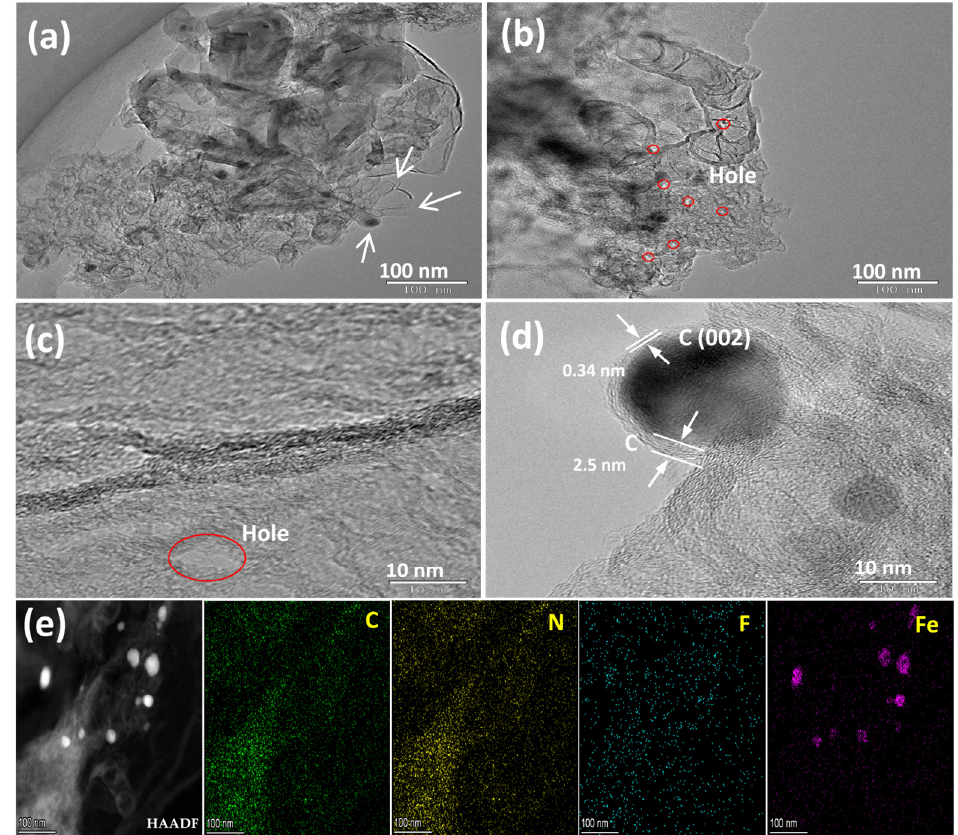
Figure 1. ( a , b ) TEM images and ( c , d ) HRTEM images of Fe 3 C@N-F-GCNTs (the white arrows in ( a ) show the bamboolike carbon nanotubes formed; the nanoholes formed were labelled with red cir- cles ( b , c )); ( e ) HAADF-STEM image and corresponding elemental mapping images for Fe 3 C@N-F-